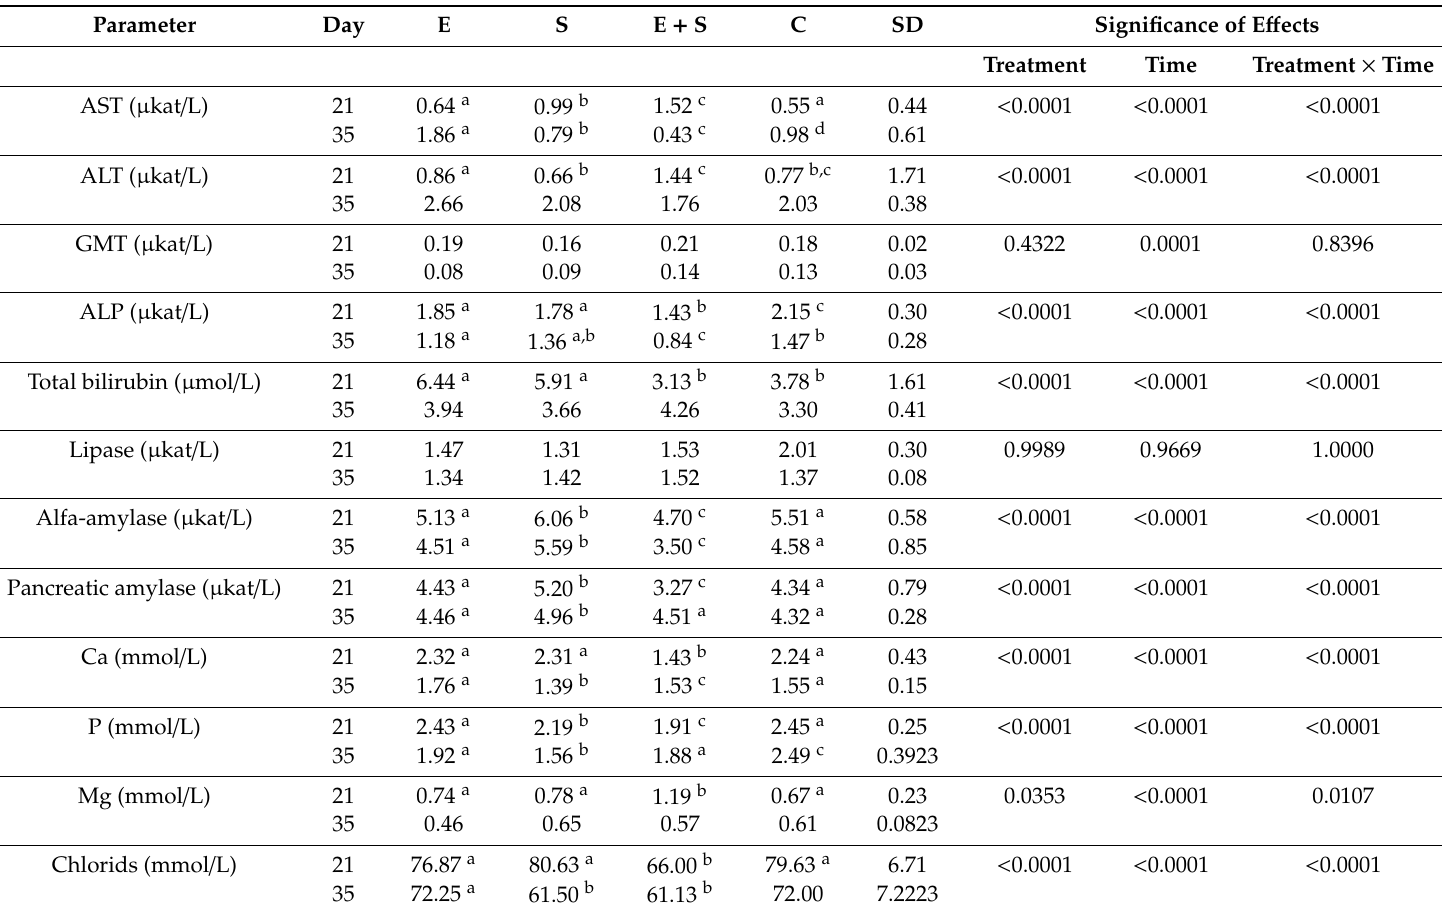
Table 5. The e ff ect of E, S, and E + S dietary supplementation on the blood protein and energetic profile of rabbits.